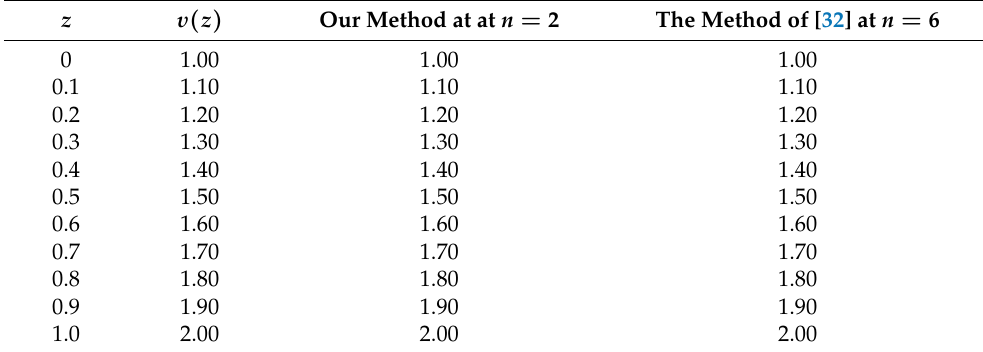
Table 3. Comparison of approximate solution of Example 1.